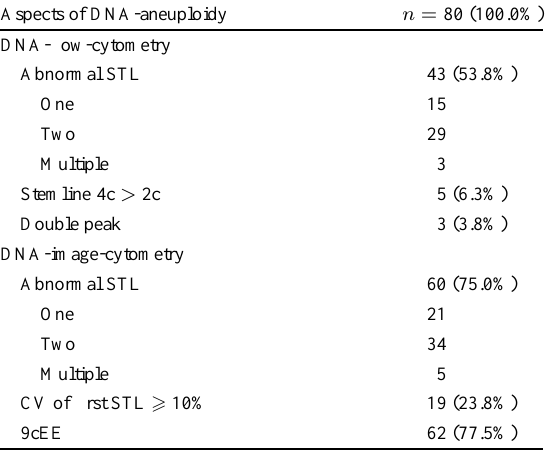
Prevalence of different aspects of DNA-aneuploidy in cytologi- cally equivocal effusions (DNA-flow- and -image-cytometry) (STL = stemline; CV = coefficient of variation; 9cEE = 9c exceeding events) Aspects of